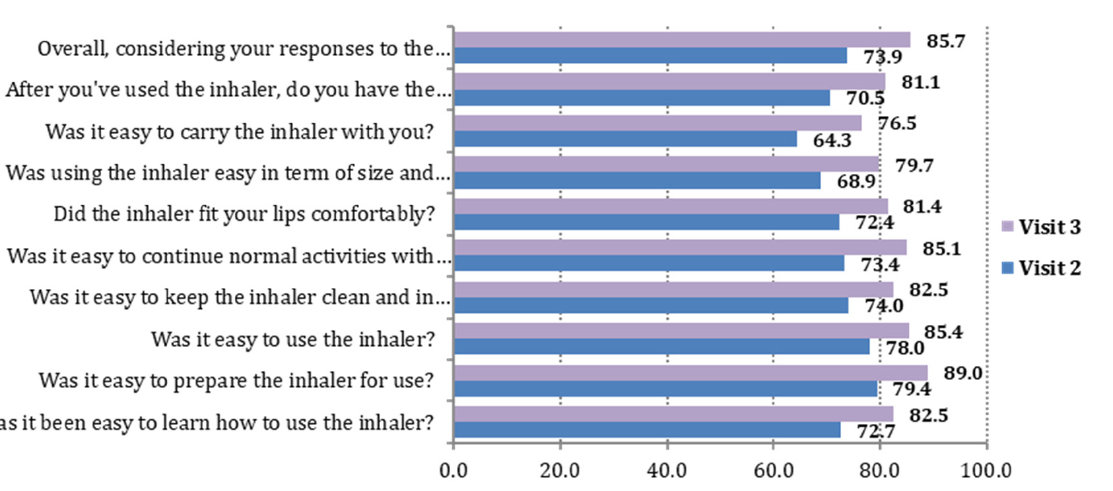
Table 2. FSI-10 Questionnaire: distribution of each of the 10 items during the two visits after baseline.